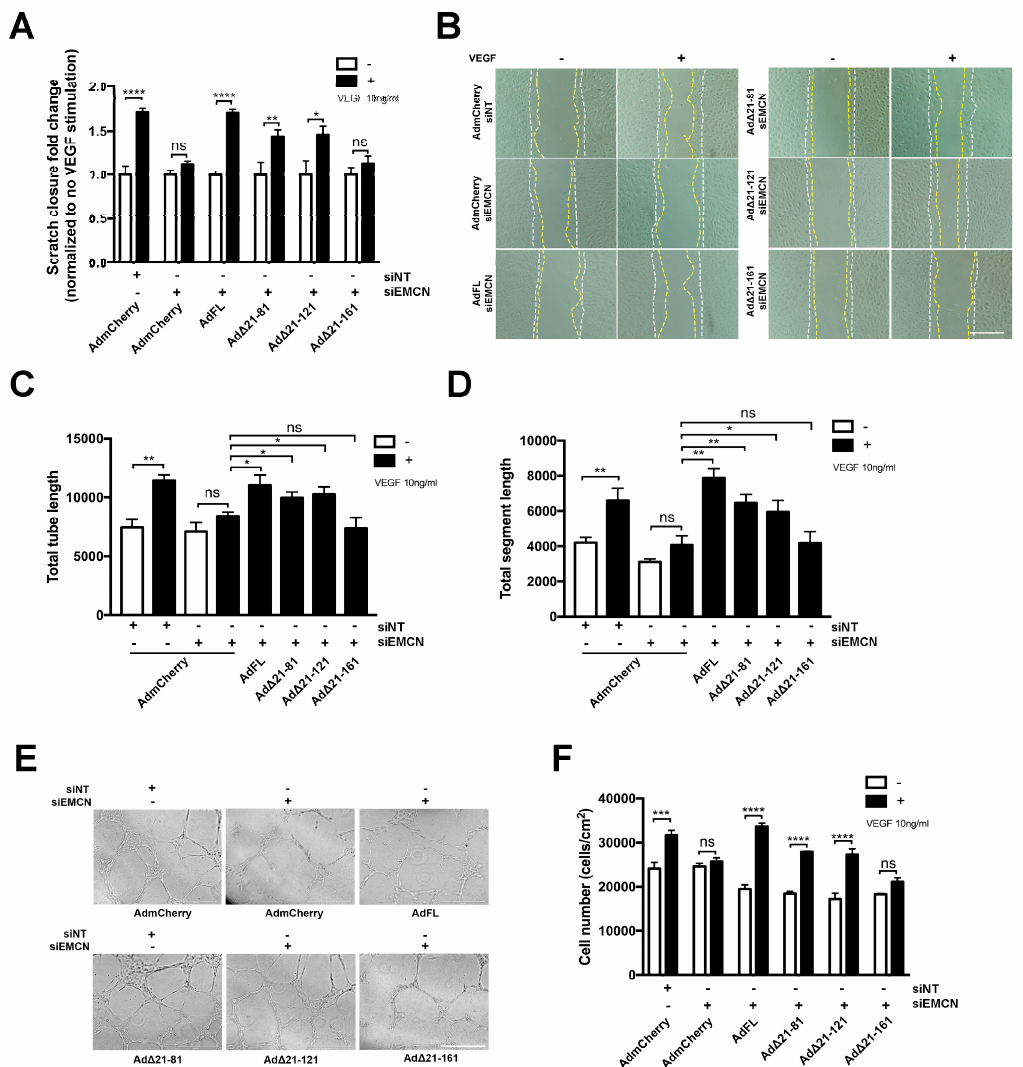
Figure 2. ∆ 21-121 EMCN is the minimal truncation mutant to rescue vascular endothelial growth factor (VEGF)-induced migration, tube formation, and cell proliferation of primary human endothelial cells. ( A ) HRECs were transduced with adenoviruses expressing the FL and di ff erent EMCN mutants individually, and endogenous hEMCN was knocked down using siRNA with non-targeting siRNA (siNT) as control. Then, VEGF-stimulated closure percentage was normalized to that without VEGF for each treatment group. EMCN knockdown abolished VEGF-induced migration, and ∆ 21-161EMCN failed to rescue, unlike other mutants. ( B ) Representative images of cell migration: The white line indicates the initial wound area (0 h), and the yellow line marks the wound area after 15 h. Plus and minus indicates the addition of VEGF. Scale bar: 100 um ( C , D ) Tube formation by HREC at 6 h was recorded, and the total tube length and total segment length were quantified using Image J angiogenesis plug-in in a masked fashion. The FL EMCN, ∆ 21-81, and ∆ 21-121 all rescued VEGF-induced tube formation whereas ∆ 21-161 did not. ( E ) Representative images for the tube formation assay. Scale bar: 400 µ m. ( F ) HRECs were incubated in serum-free media with and without 10 ng / mL VEGF and cell number following 48 h of incubation quantified. The FL EMCN, ∆ 21-81, and ∆ 21-121 all rescued VEGF-induced HREC proliferation whereas ∆ 21-161 did not. All data = mean ± SEM, ns, not significant, * p < 0.05, ** p < 0.01, *** p < 0.001 and **** p < 0.0001 by 2-tail unpaired t-test, n ≥